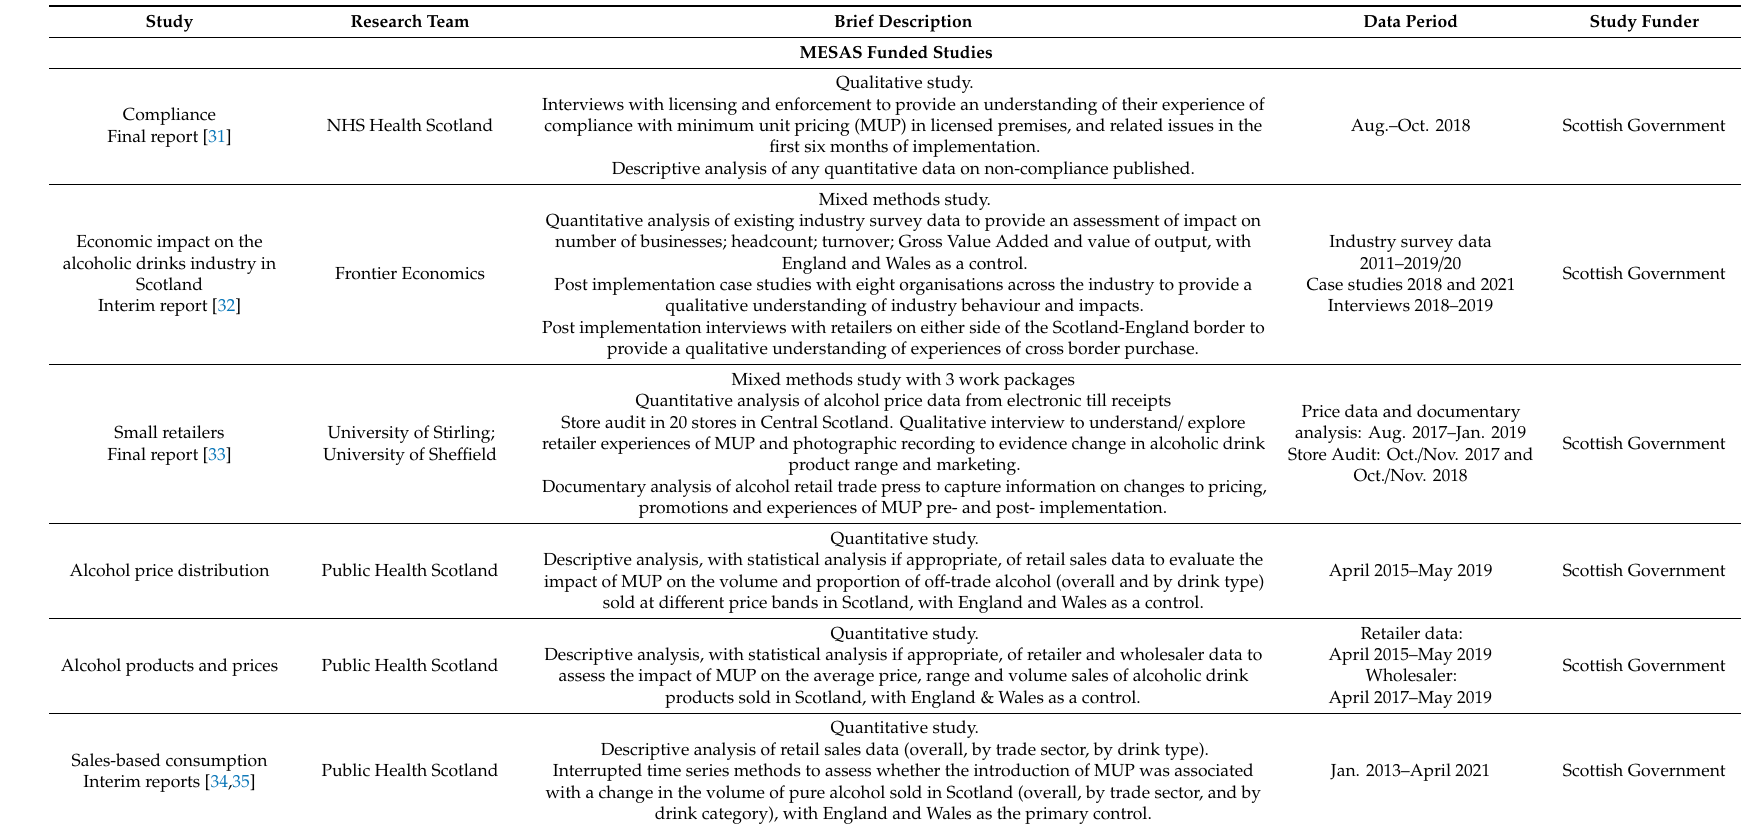
Table A1. Brief description of MESAS-funded studies, data period, research team and